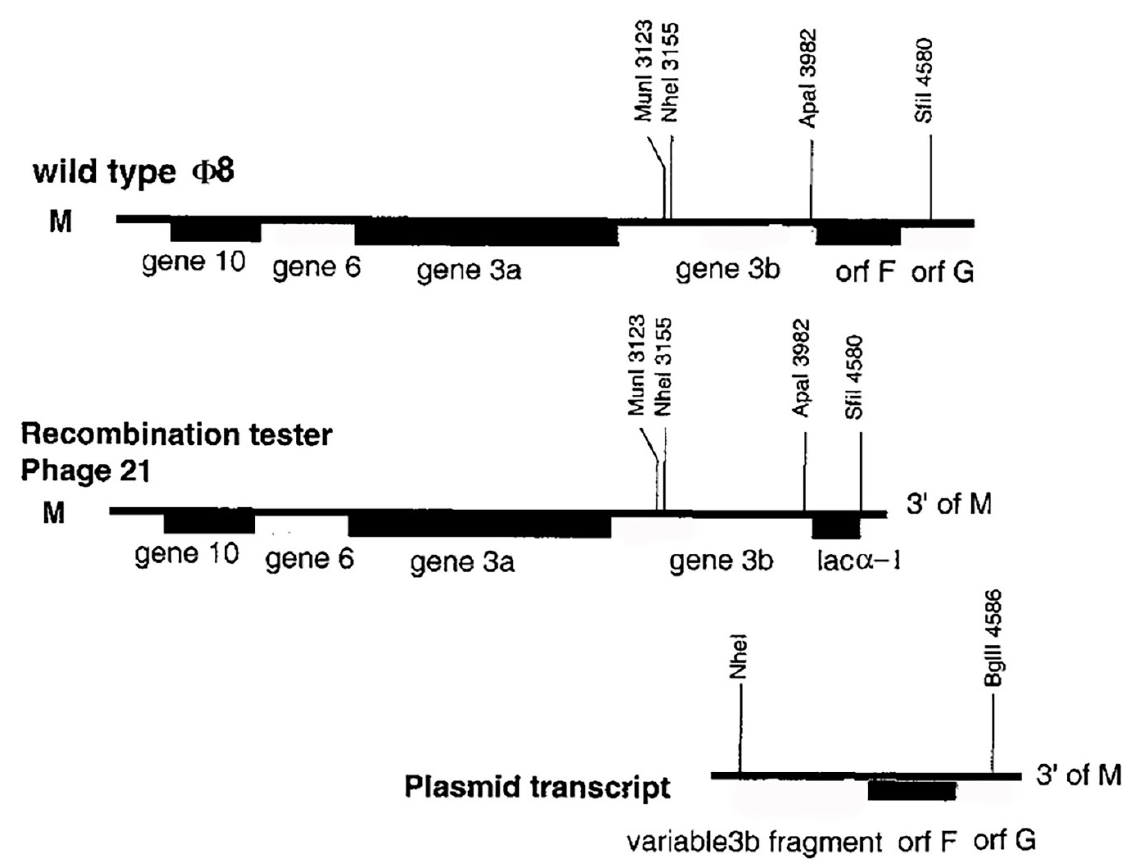
Figure 10. The cDNA copy of ϕ 8 M and the tester phage 21 with lac α in place of genes F and G. The complemented plasmid transcript was of variable size compared to the 3b gene. Reproduced from Onodera et al. (2001).